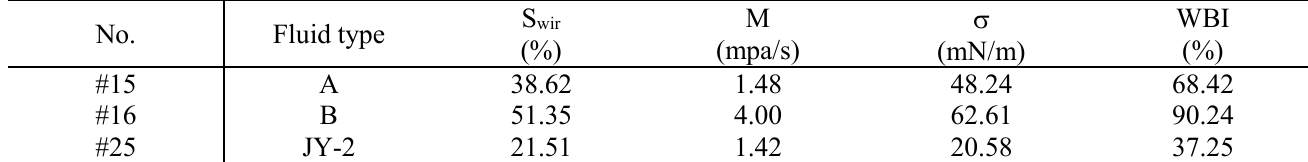
Table 3—Results of WBI for different